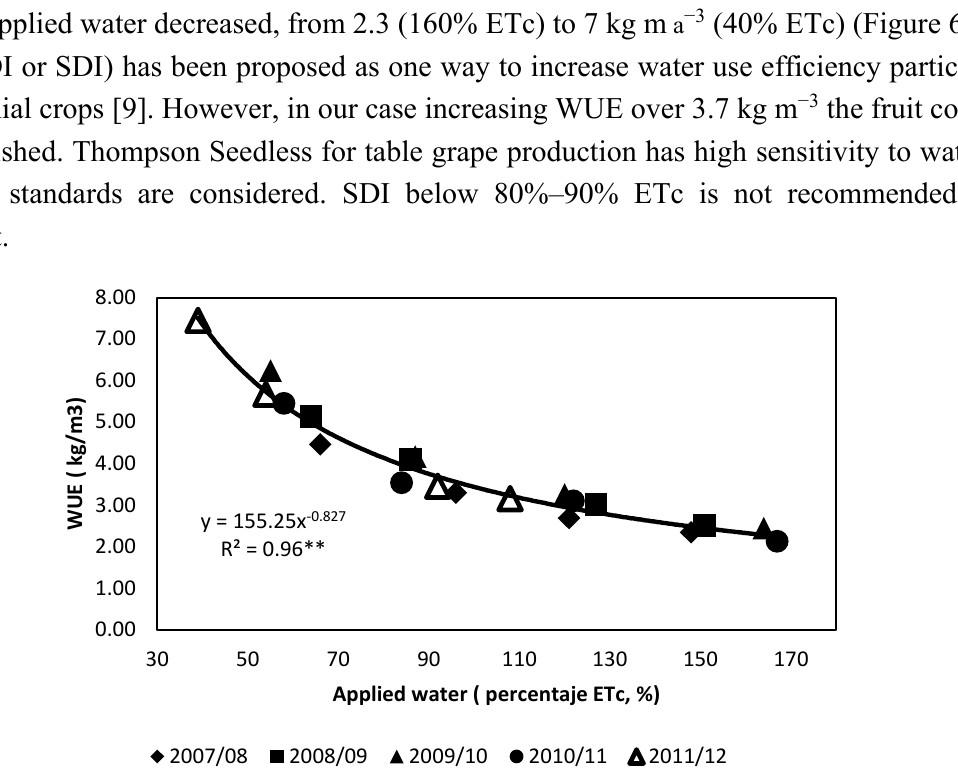
Figure 6. Water use efficiency (kg of fresh fruit per cubic meter of applied water, kg m −3 ) as a function of applied water (%